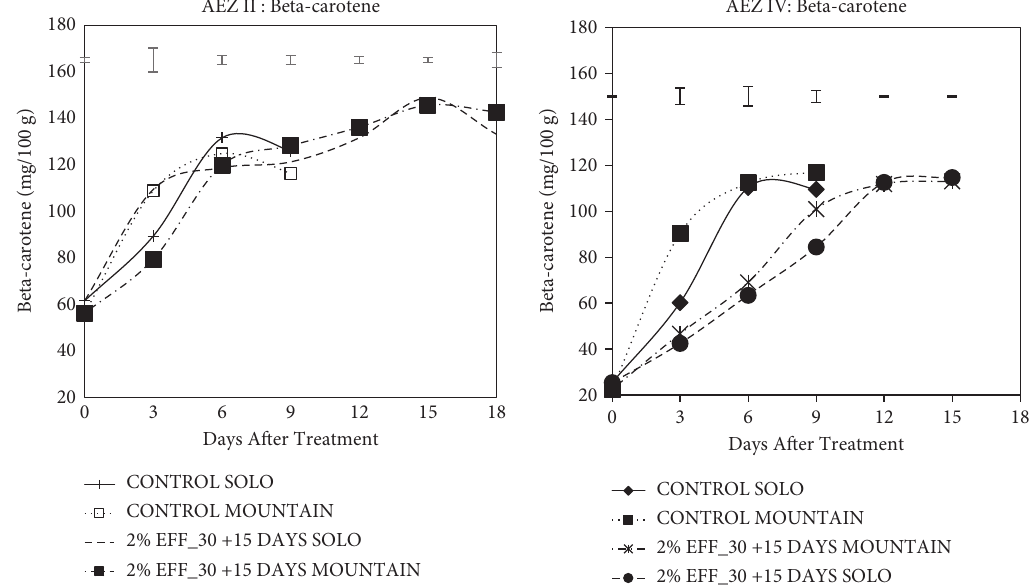
Figure 9: Beta-carotene content of papaya fruits treated with Hexanal spray from Machakos and Meru counties. Top bars represent LSD at